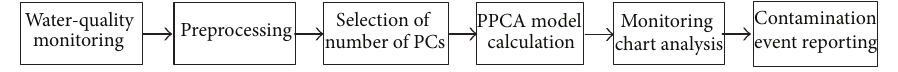
Figure 1: Schematic of proposed probabilistic principal component analysis- (PPCA-) based monitoring